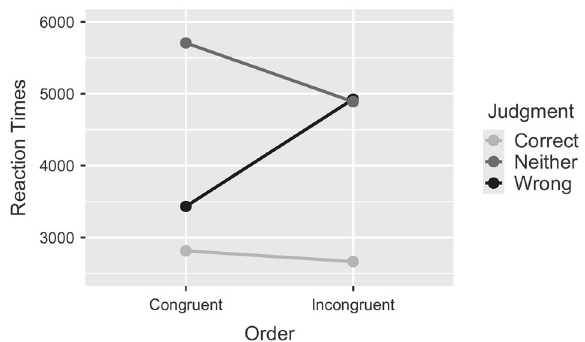
Fig. 6 A direct comparison of judgments and reaction times across orders. The y-axis shows inverse-transformed